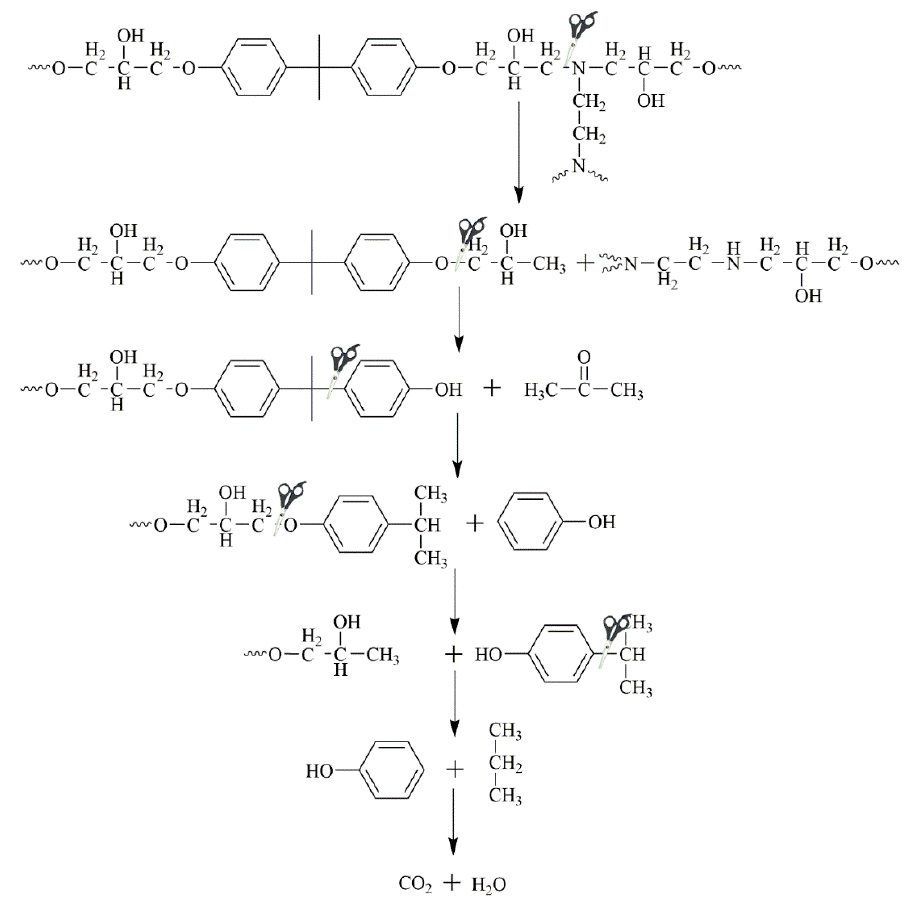
Figure 8. The proposed pathway for the electrochemical catalytic degradation of DGEBA/EDA.